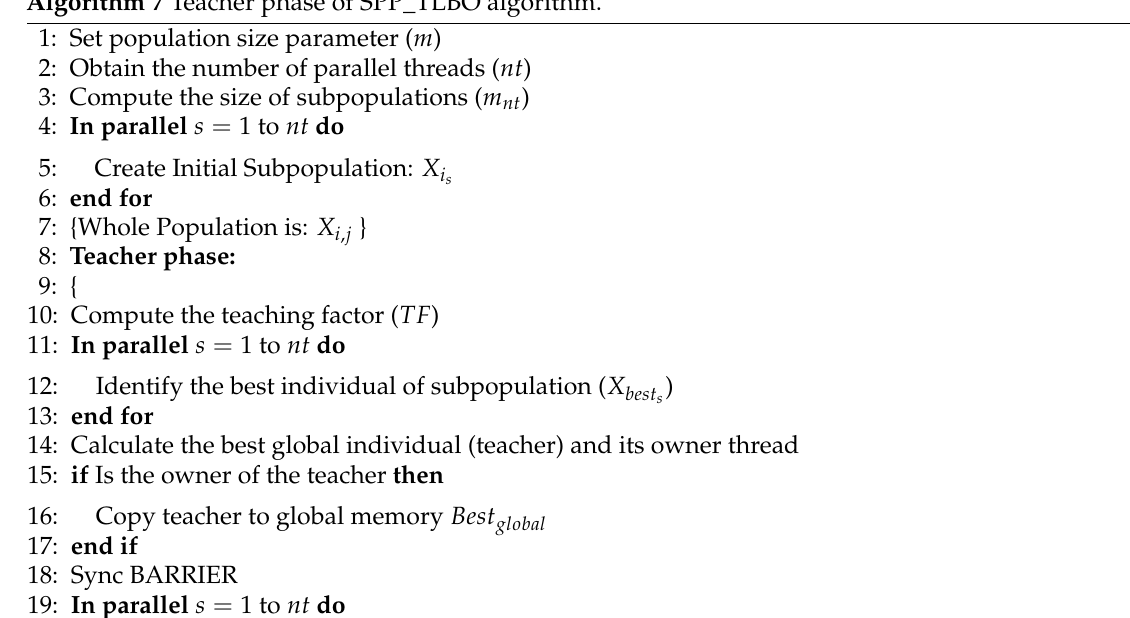
Algorithm 7 Teacher phase of SPP_TLBO